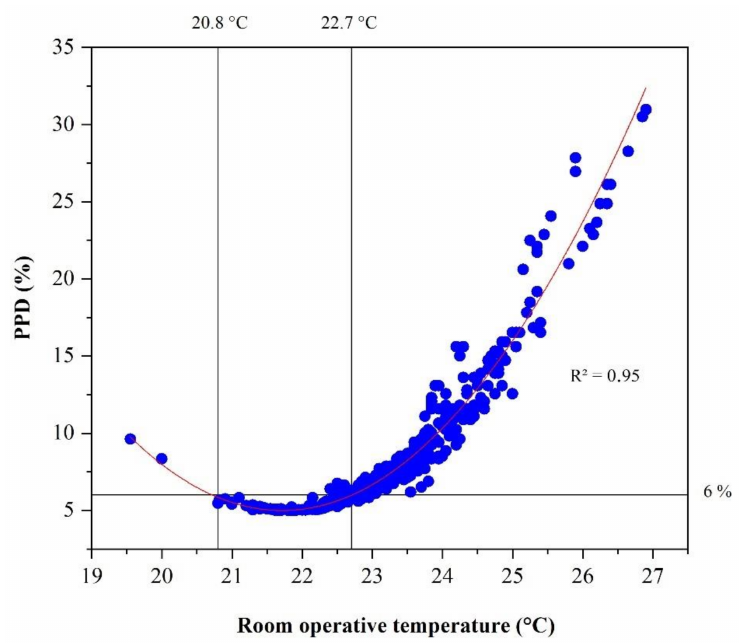
Figure 8. Predicted percentage of dissatisfaction versus operative